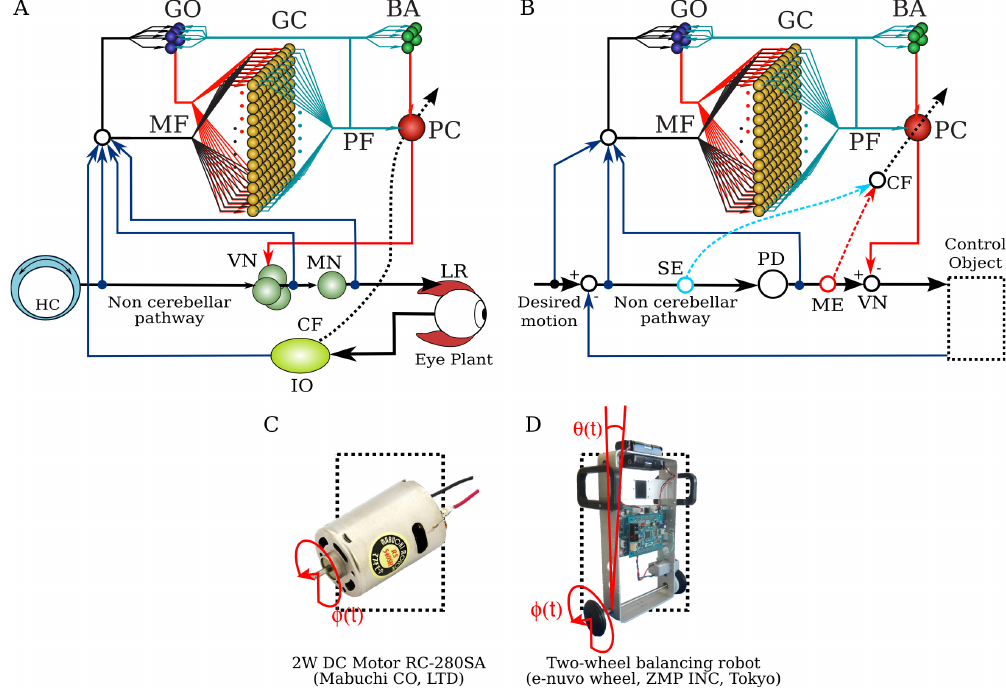
Figure 1. Neural circuit of the horizontal vestibulo-ocular reflex (VOR) and cerebellar neuronal network (CNN) model. ( A ) The neural circuit of the horizontal VOR. CF, climbing fiber; GO, Golgi cell; GC, granule cell; HC, horizontal canal; IO, inferior olive; LR, lateral rectus muscle of the eye; MF, mossy fiber; MN, motor neuron; BA, basket/stellate cell; PC, parallel fibers; VN, vestibular excitatory/inhibitory neurons. Blue and red lines indicate excitatory and inhibitory action, respectively. The dashed line shows the CF. ( B ) The structure of the CNN model with a proportional and derivative (PD) feedback controller that represents the non-cerebellar pathway depicted in (A). Labeled dashed lines show the origin of the sensory error (SE) (blue dashed line) and motor error (ME) (red dashed line) sources of CF, respectively. ( C ) A 2-W direct current motor with 1 degree of freedom (DOF). The control variable is shaft angular position φ ( t ) . ( D ) Two-wheeled balancing robot with 2 DOFs. The control variables are wheel angular position φ ( t ) and body tilt angle θ ( t )